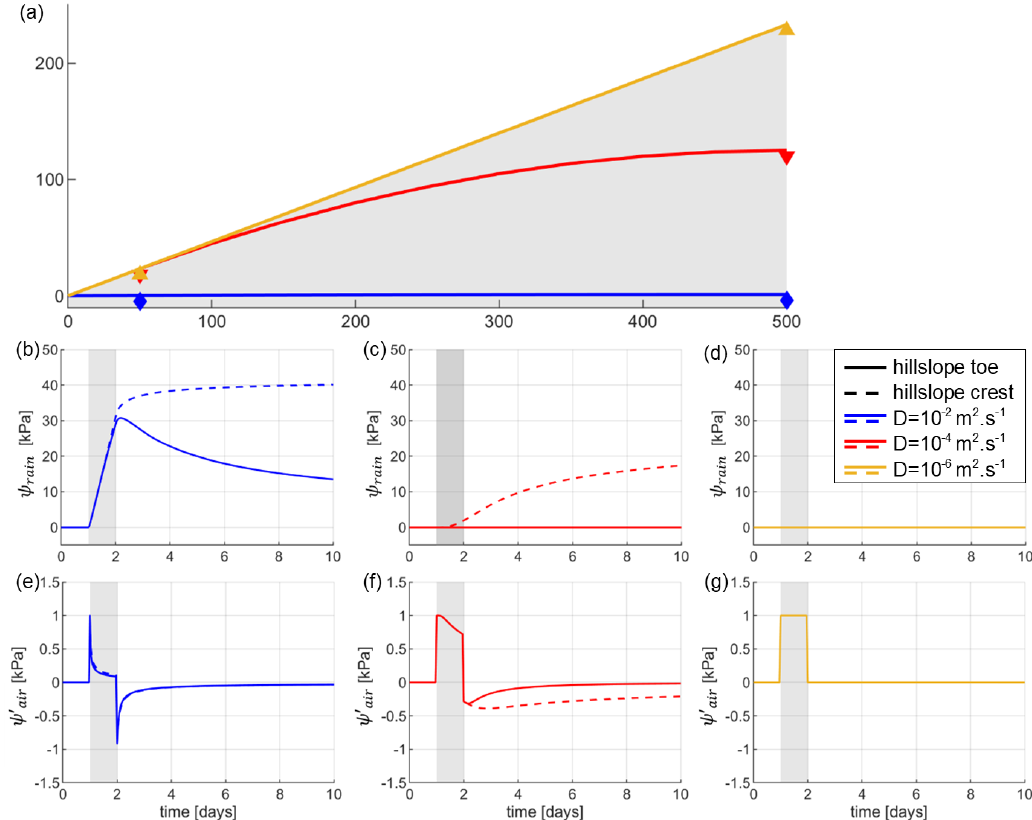
Figure 4. Initial state of the water table in the hillslope (a) after a static recharge of 10 − 9 ms − 1 and investigated points at the crest and toe (e–g) in response to the synthetic forcing (Fig. 2), at several diffusivities. Solid of the hillslope. Temporal evolution of ψ rain (b–d) and ψ (cid:48) air lines represent atmospheric and rainfall effects at the toe of the hillslope at x = 50m, and dashed lines the effect at the crest of the hillslope at x =